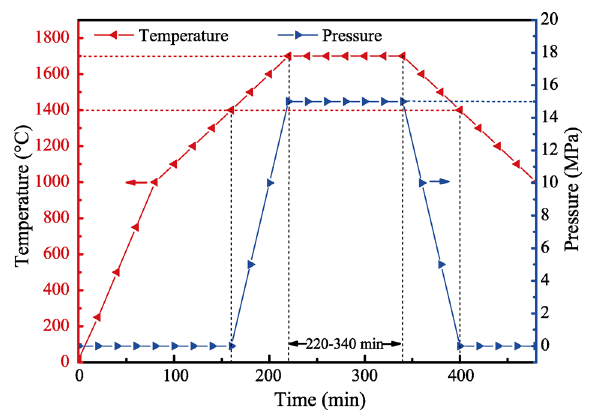
Fig. 1 Diagram of hot-press sintering procedure. 120 min (from 220 to 340 min) at 1750 ℃ , and then reduced linearly as the temperature decreased. When the temperature was 1400 ℃ , the pressure dropped to 0 MPa. After cooling, the CM 2 A 8 and C 2 M 2 A 14 ceramics were obtained.